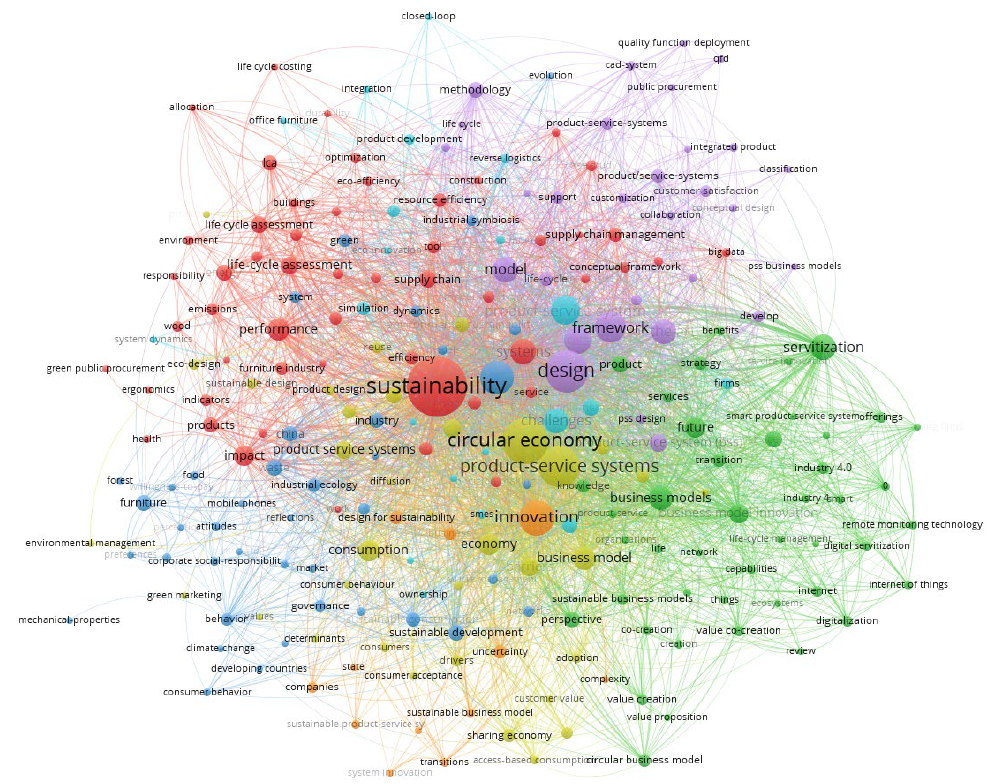
Figure 2. Keywords co-occurrence network visualization of furniture and PSSs in the context of circular economy (CE) and sustainability (generated by authors).